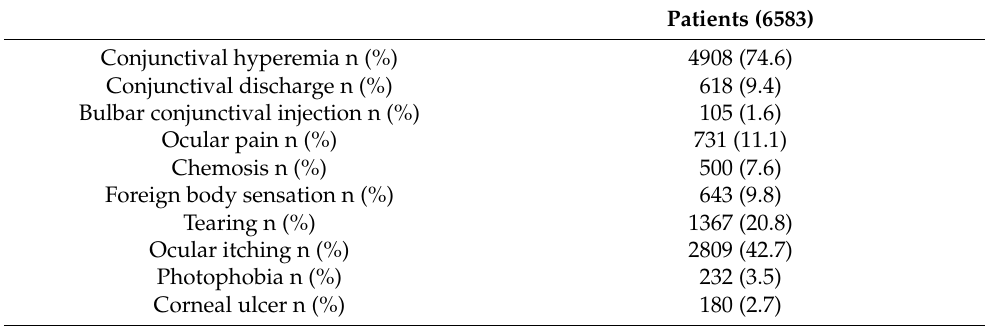
Table 3. Signs and symptoms in patients with acute bacterial conjunctivitis.